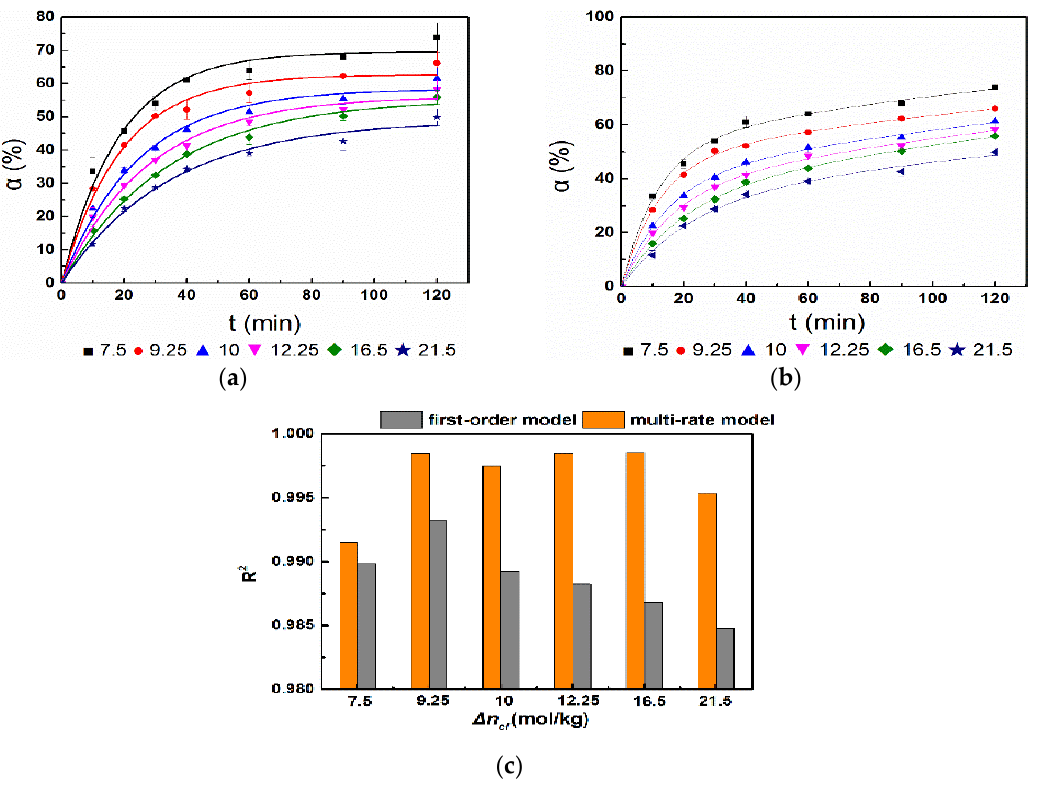
Figure 2. Simulation of the magnesium oxide hydration rate under an unforced condition: Figure 2. ( a ) First-order model; ( b ) multi-rate model; ( c ) correlation coefficient.